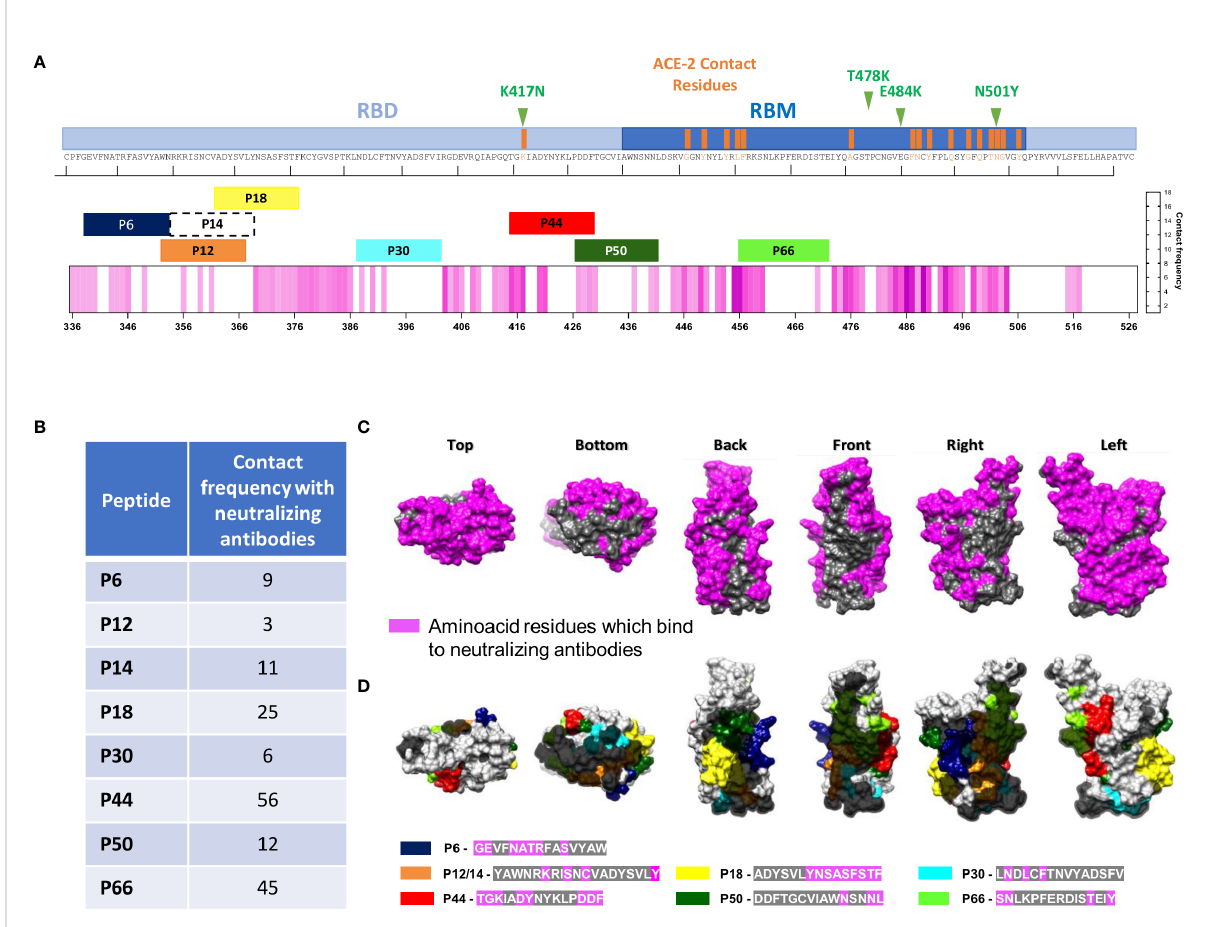
FIGURE 5 Structural localization of the eight most recognized peptides and monoclonal binding faces of RBD. (A) Linear RBD sequence showing the RBM region, highlighting ACE-2 contact residues. Top eight IgG and/or IgA recognized peptides (P6, P12, P14, P18, P30, P44, P50 and P66) are shown according to RBD residues. The pink heatmap represents the frequency at which nAbs contact each amino acid in RBD, according to a previous review (18). Mutation sites are shown in green in upper part. (B) Frequency of nAbs in contact with each amino acid in the RBD depicted in (A, C) . Surface structure of different RBD views showing regions where neutralizing antibodies bind to (in pink), and three non- neutralizing faces, in gray. (D) Top recognized peptides are shown in colors and non-neutralizing faces are highlighted in gray according to